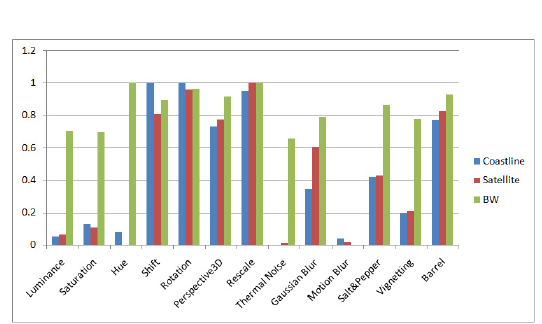
Figure 14. Distortion - Mosaicing PSNR Fidelity